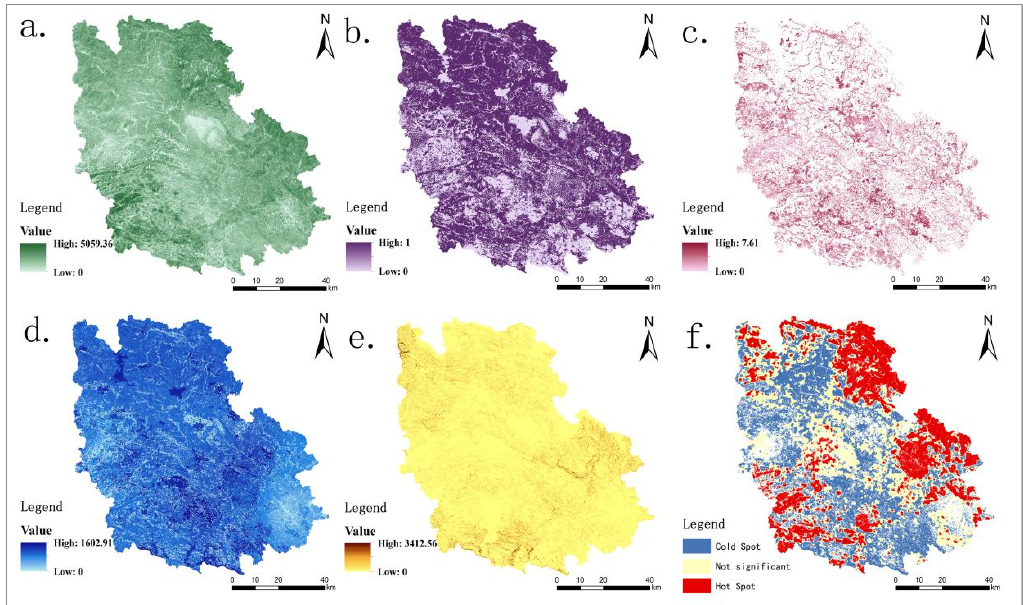
Figure 4. The spatial pattern of ecosystem services and the distribution of cold and hot areas. ( a ) NPP (gC·m –2 ·a –1 ); ( b ) Habitat maintenance; ( c ) Food supply (MkJ/km 2 ); ( d ) Water resources supply (mm); ( e ) Soil conservation (t·hm –2 ·a –1 ); ( f ) Cold and hot areas.